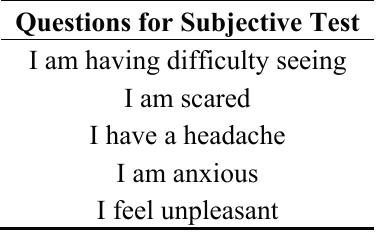
Figure 12. Experimental procedure for measuring fear (BR is blinking rate, FT is facial temperature and SE means subjective evaluation). Table 3. Contents of the questionnaire for the subjective